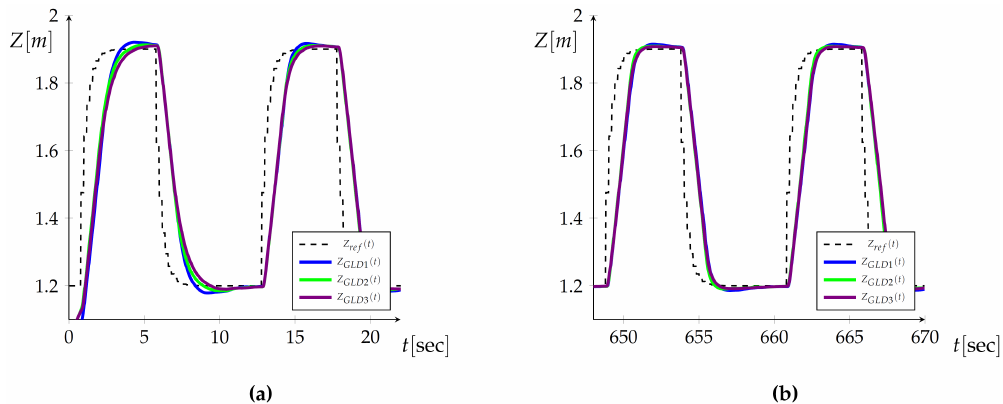
Figure 9. Time courses for: ( a ) first two iterations of the GLD method (mistuned gains), ( b ) last two iterations (well-tuned gains) for Z GLD 1 ( α = 1.0, β = 0.0), Z GLD 2 ( α = 0.9, β = 0.1), Z GLD 3 ( α = 0.8, β = 0.2).